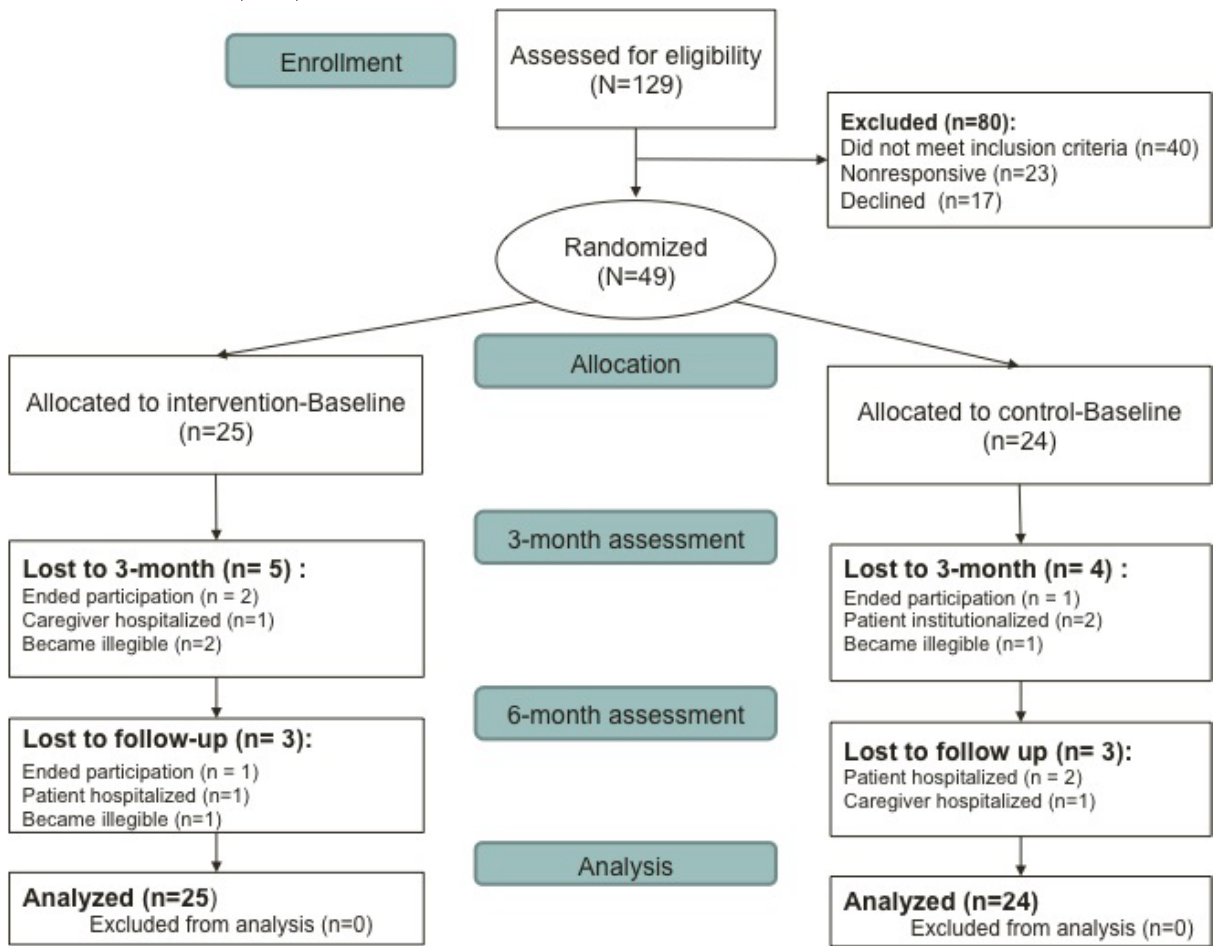
Figure 2. Flowchart of the Diapason pilot randomized controlled